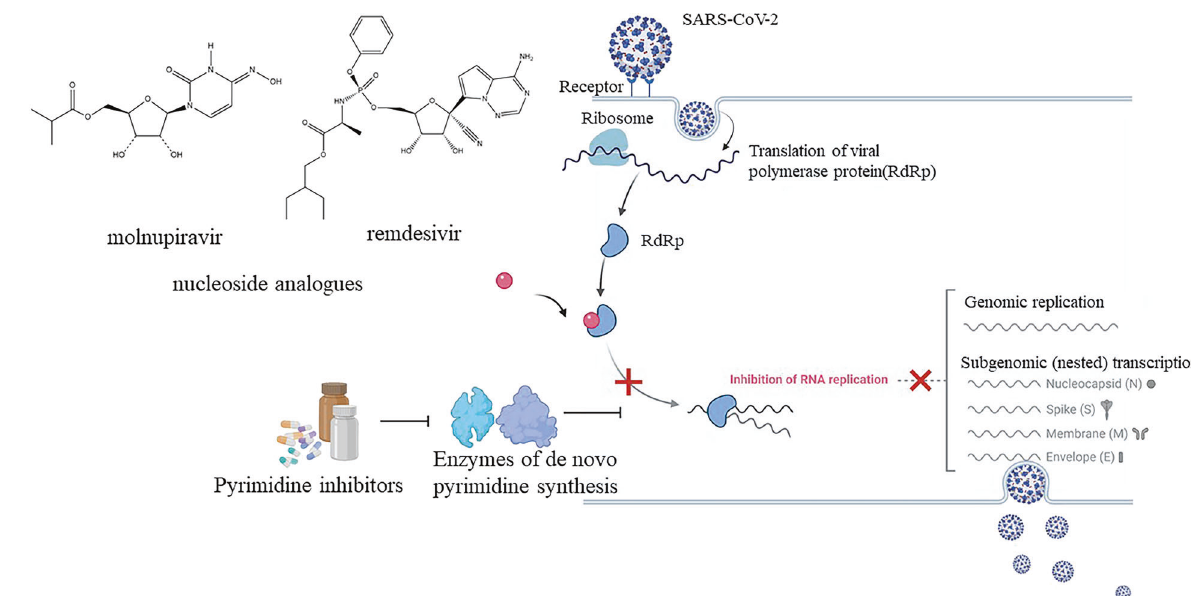
Fig. 1 Pyrimidine biosynthesis inhibitors and antiviral nucleoside analogues synergistically inhibit SARS-CoV-2 replication in vitro and in vivo. The combining pyrimidine biosynthesis inhibitors with antiviral nucleoside analogues suggest a new clinical forward facing the emerging strains of SARS-CoV-2. Created with